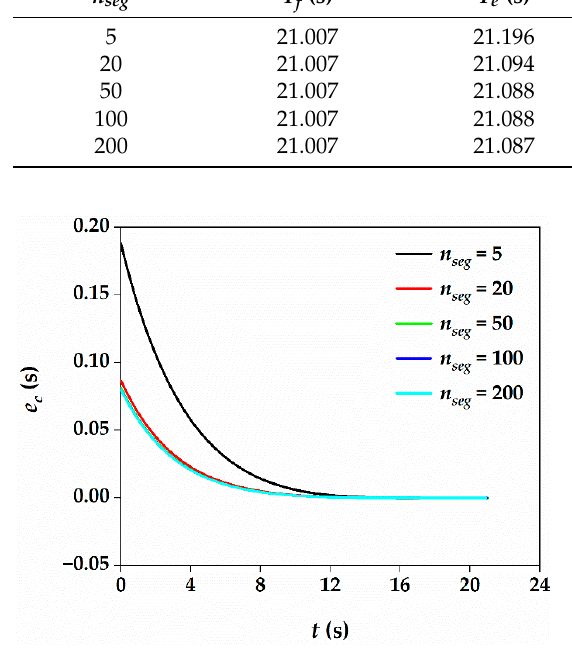
Figure 2. Simulation results under different n seg .